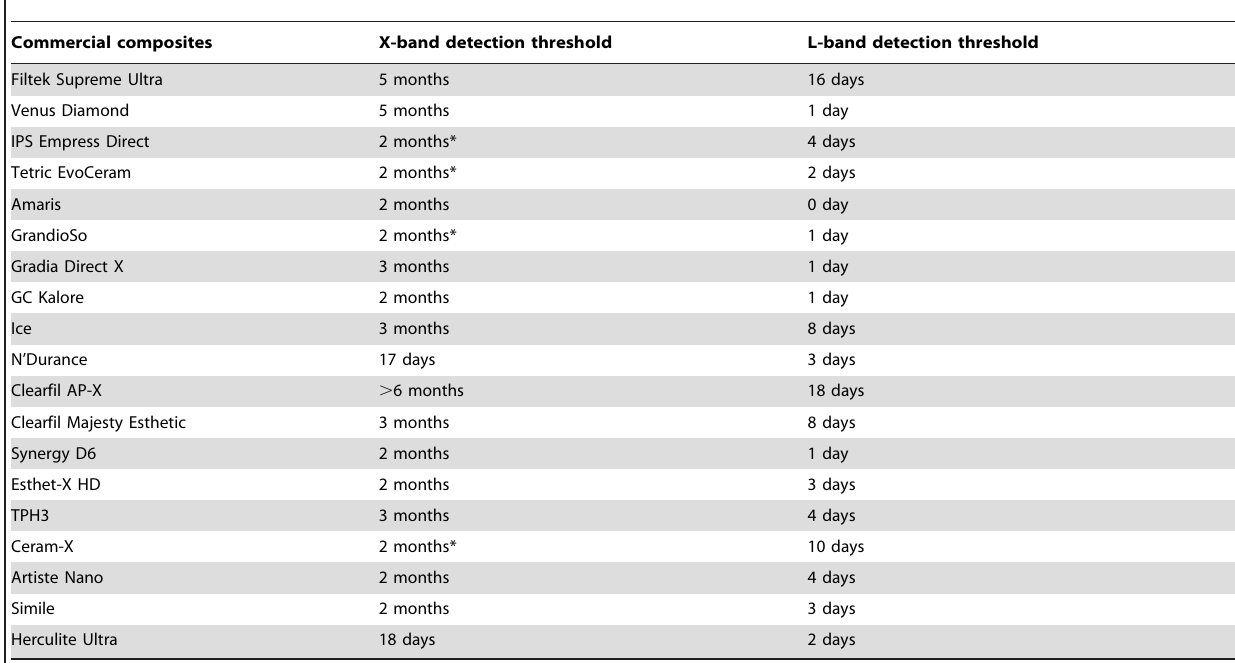
Table 7. Detection limit of the EPR signal for commercial composites, expressed as the time period needed for disappearance of the signal under the measurements conditions.